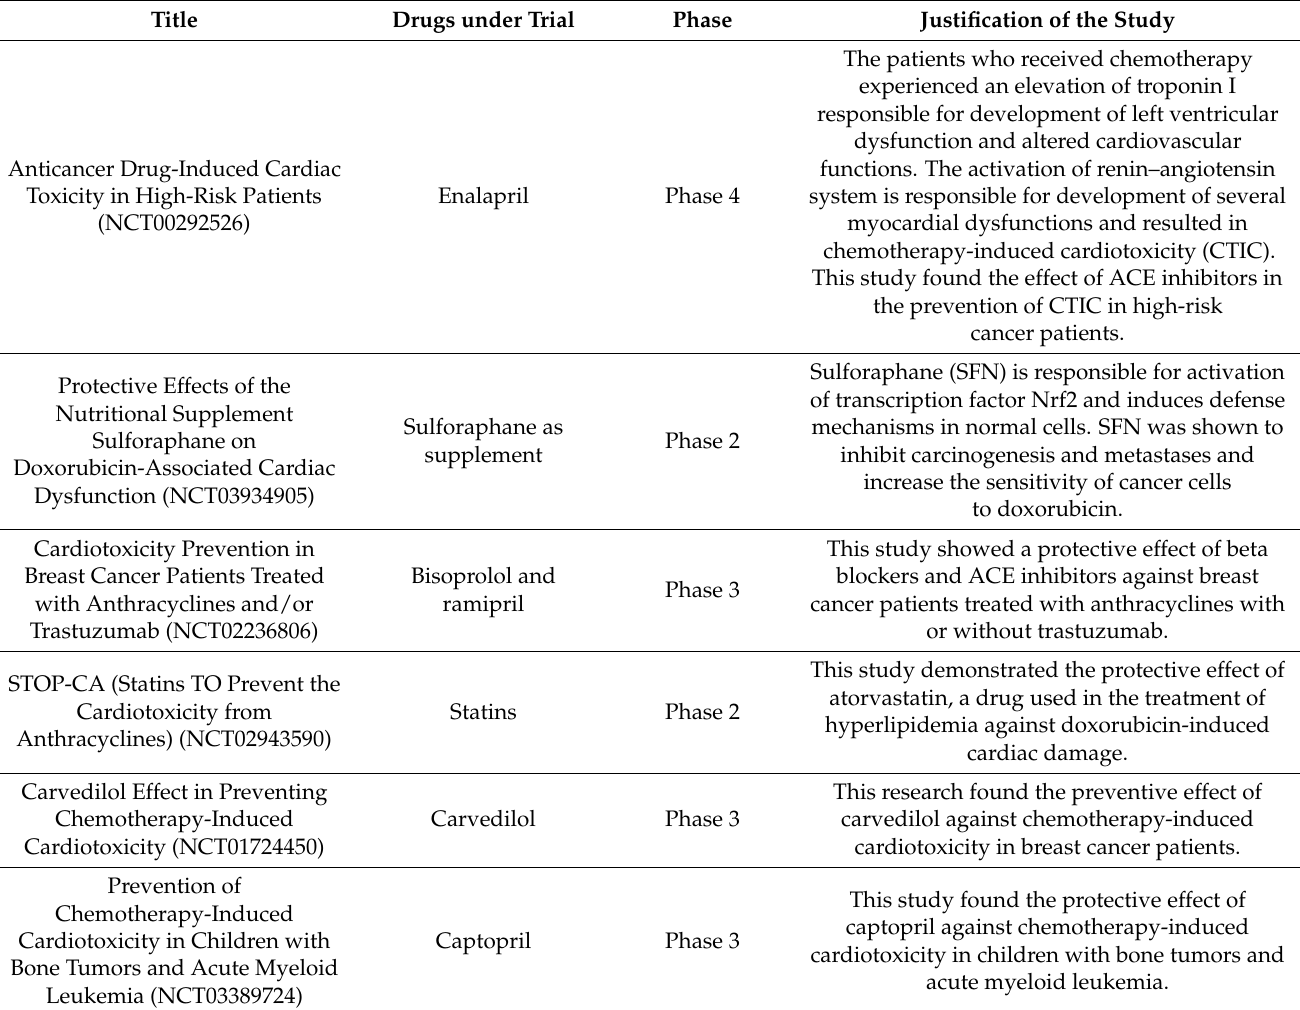
Table 3. Different agents under trial for anticancer drug-induced cardiac toxicity